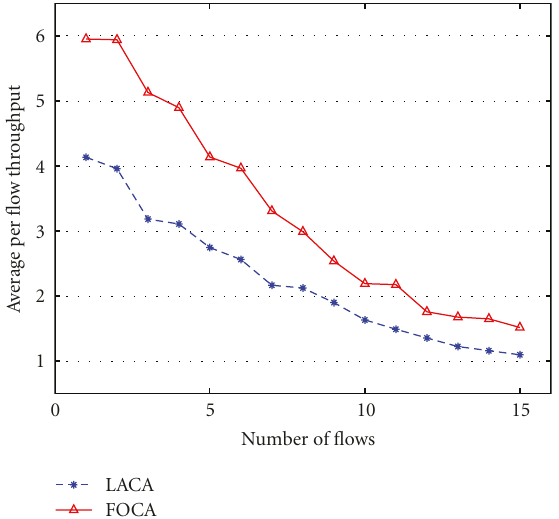
Figure 10: Scalability simulation: averaged per flow throughput versus the number of flows. Random networks are of the same size and flows are all 3-hop flows.